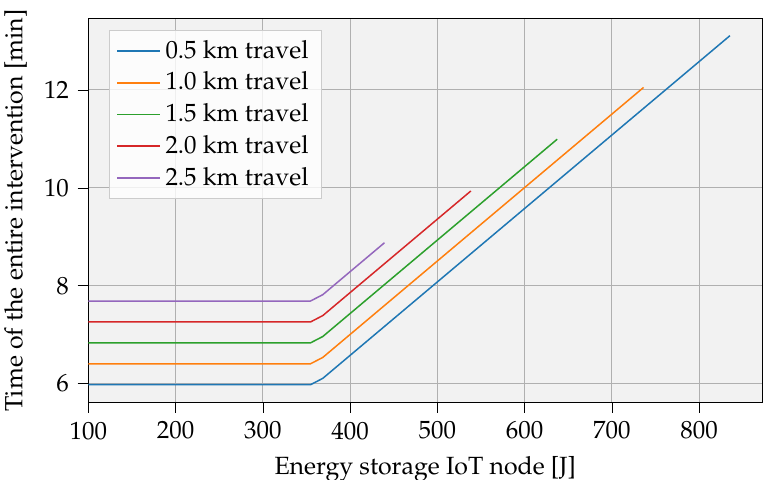
Figure 13. Overall operation time during one intervention. The same assumptions were adopted from Figure